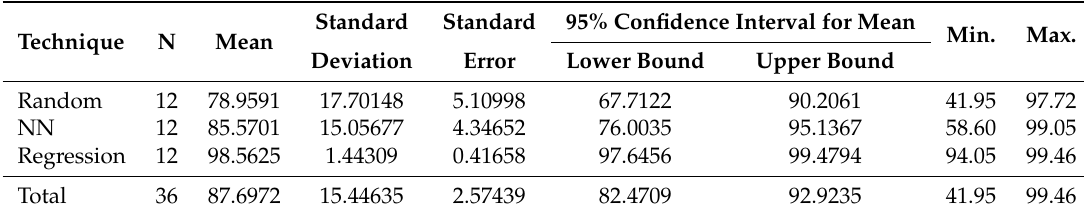
Table 9. Descriptive analysis of Random, NN and our Regression technique with respect to average